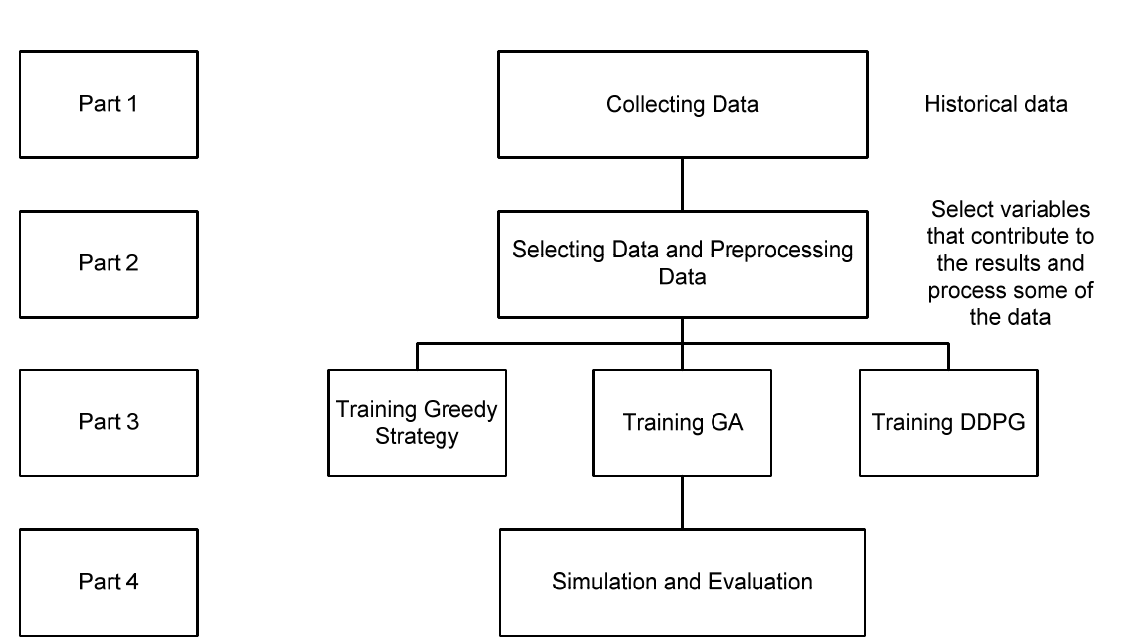
Figure 3. The Flow Chart of the Dispatching Model.